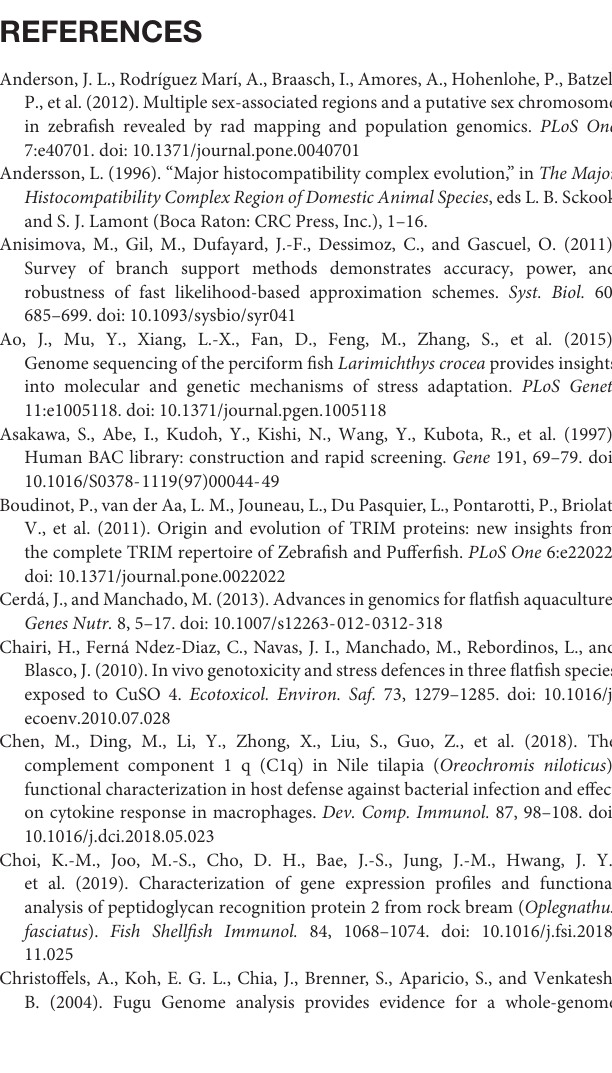
FIGURE S1 | Circos analysis in the species D. rerio. On the left side the distribution of the BAC clones of Senegalese sole distributed in chromosomes can